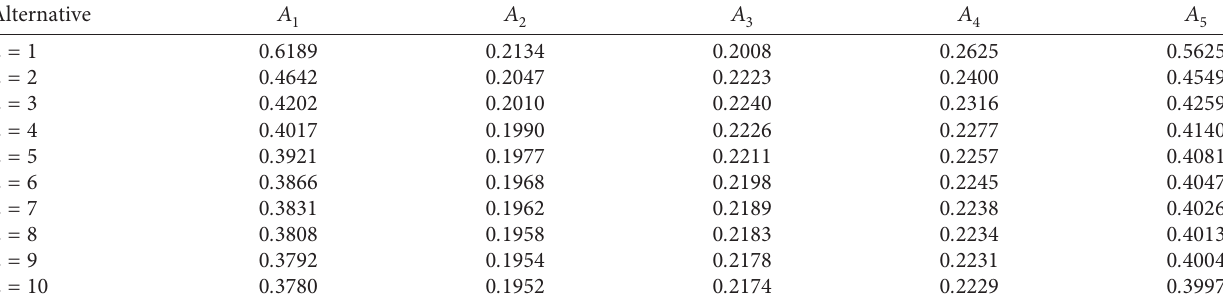
Table 18: The ration CP